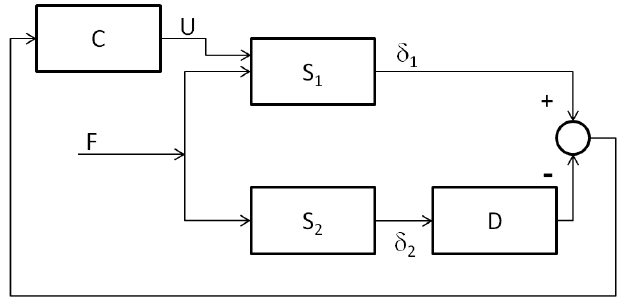
Figure 6. The control